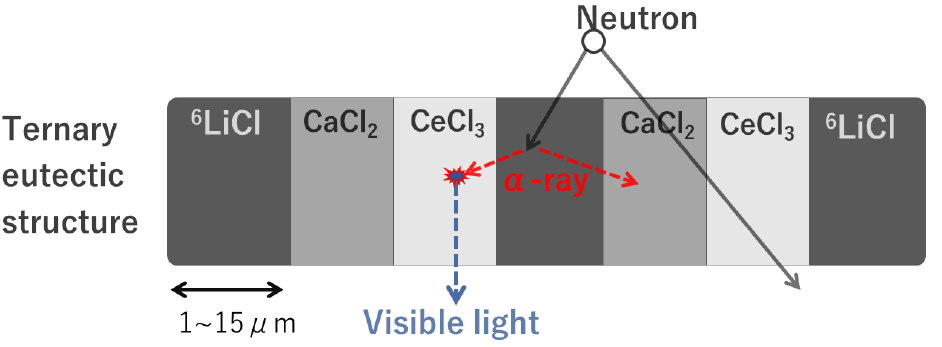
Figure 1. Schematic of the ternary eutectic scintillator in this